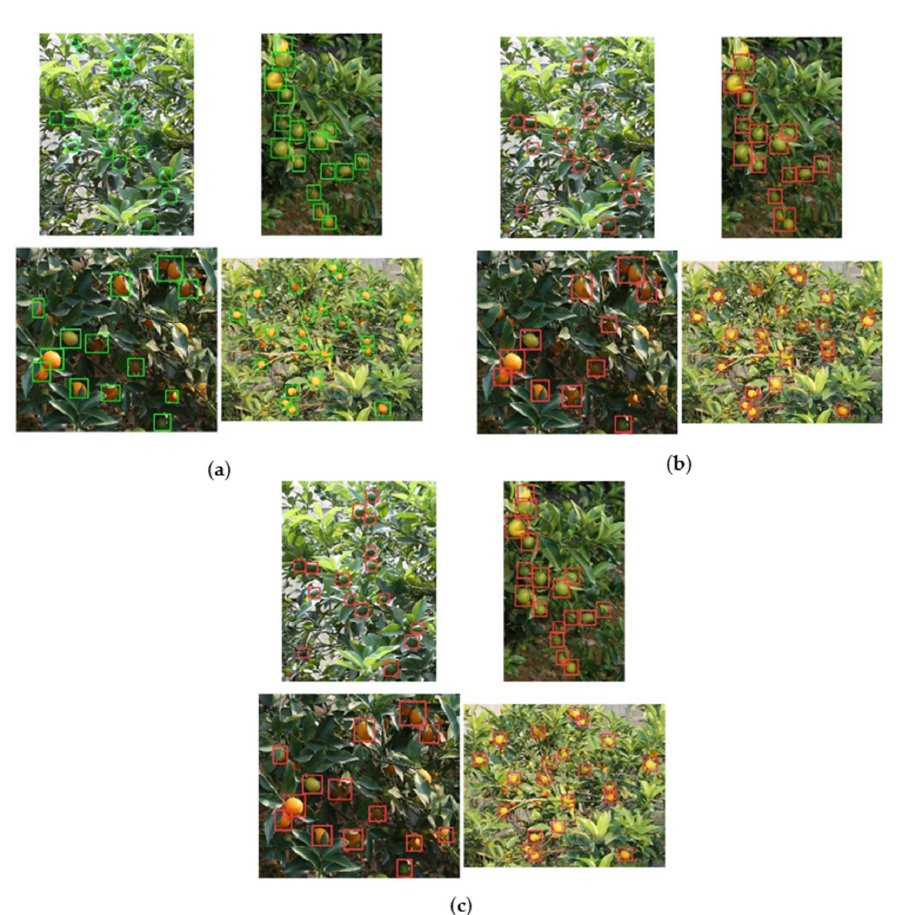
Figure 9. The comparison of detection effects in the kumquat images. ( a ) Ground truth of samples; ( b ) YOLOv51; and ( c ) improved YOLOv5. ( b ) YOLOv51; and ( c ) improved